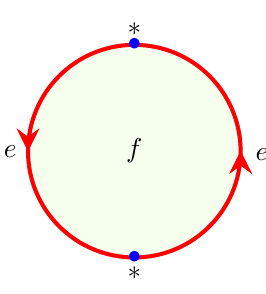
Figure 8 . The real projective plane is a disc with antipodal points of the bounding circle identified. It can be constructed by attaching a plaquette to a circle along a map of winding number